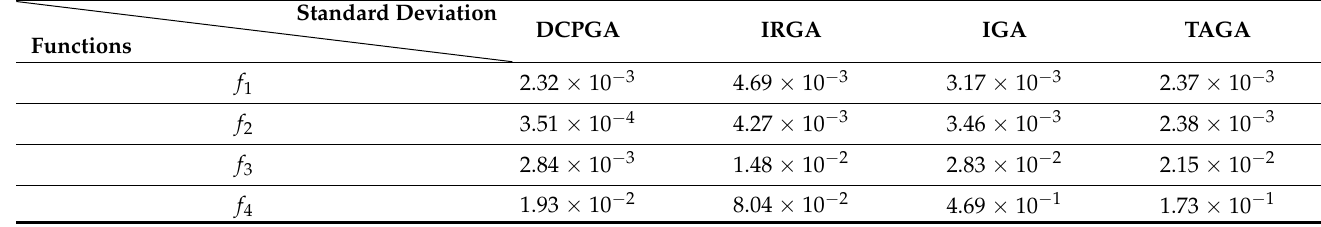
Table 1. Standard deviation comparison.